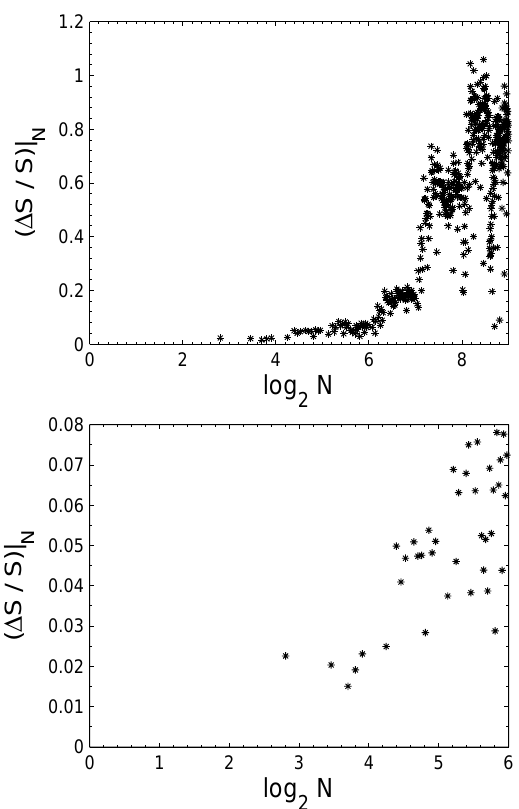
(cid:1)(cid:12) Fig. 4. (Top) (cid:0) 1S (cid:14) S (cid:12) N vs. log 2 N for every natural number N < 2 9 that represents a subset of three or more τ i ’s. (Bottom) Same as above but for N < 2 6